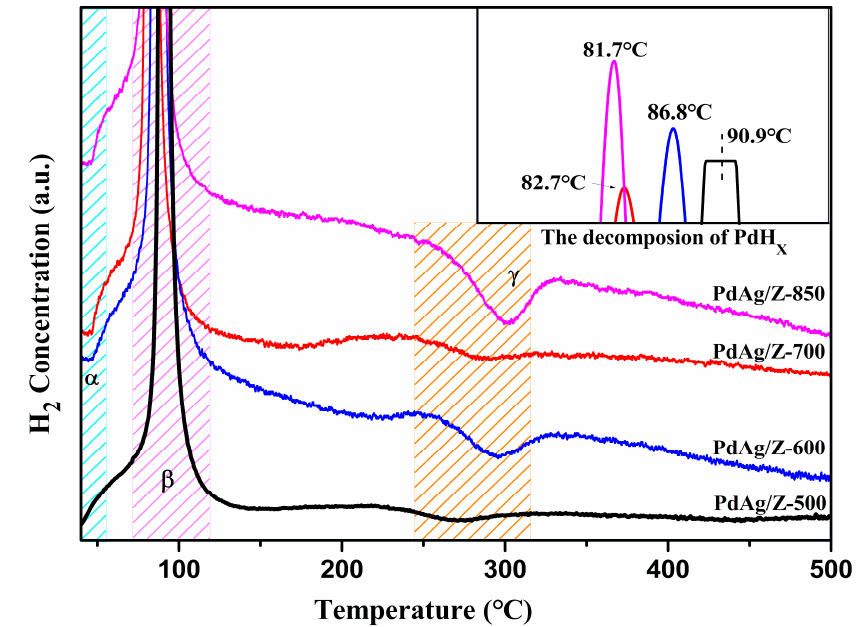
Figure 7. H 2 temperature programmed reduction (H 2 -TPR) profiles of PdAg/Z catalysts calcined at different temperatures.